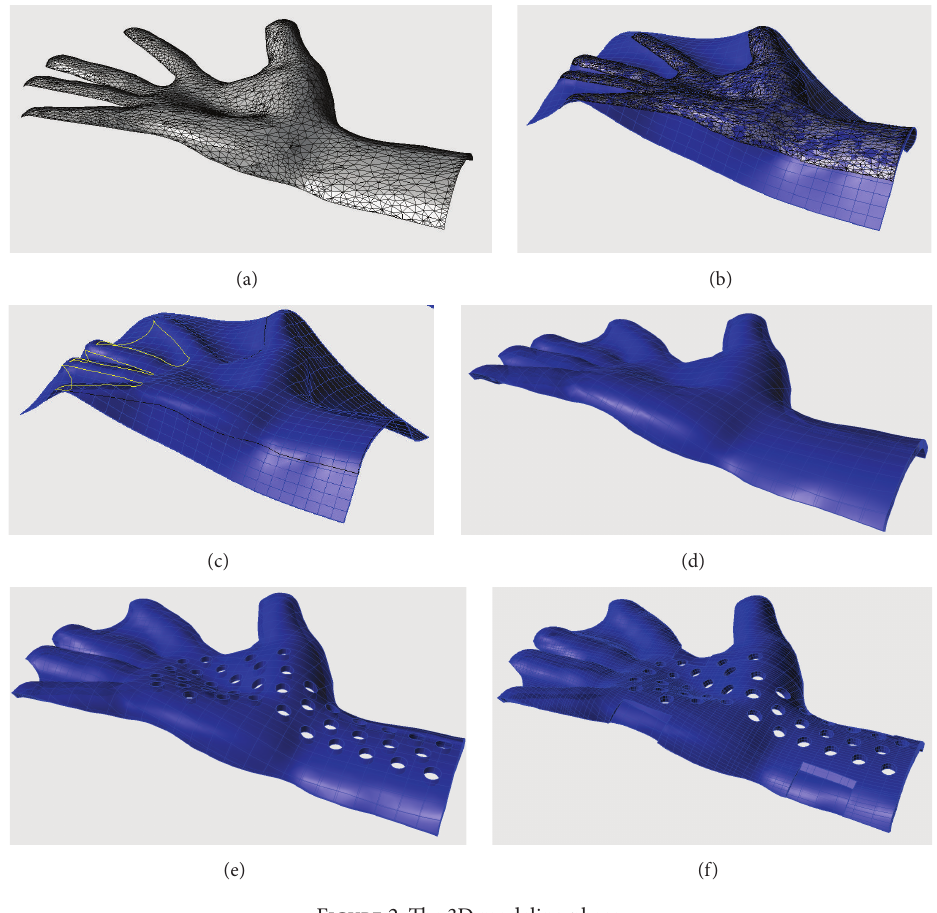
Figure 2: The 3D modeling